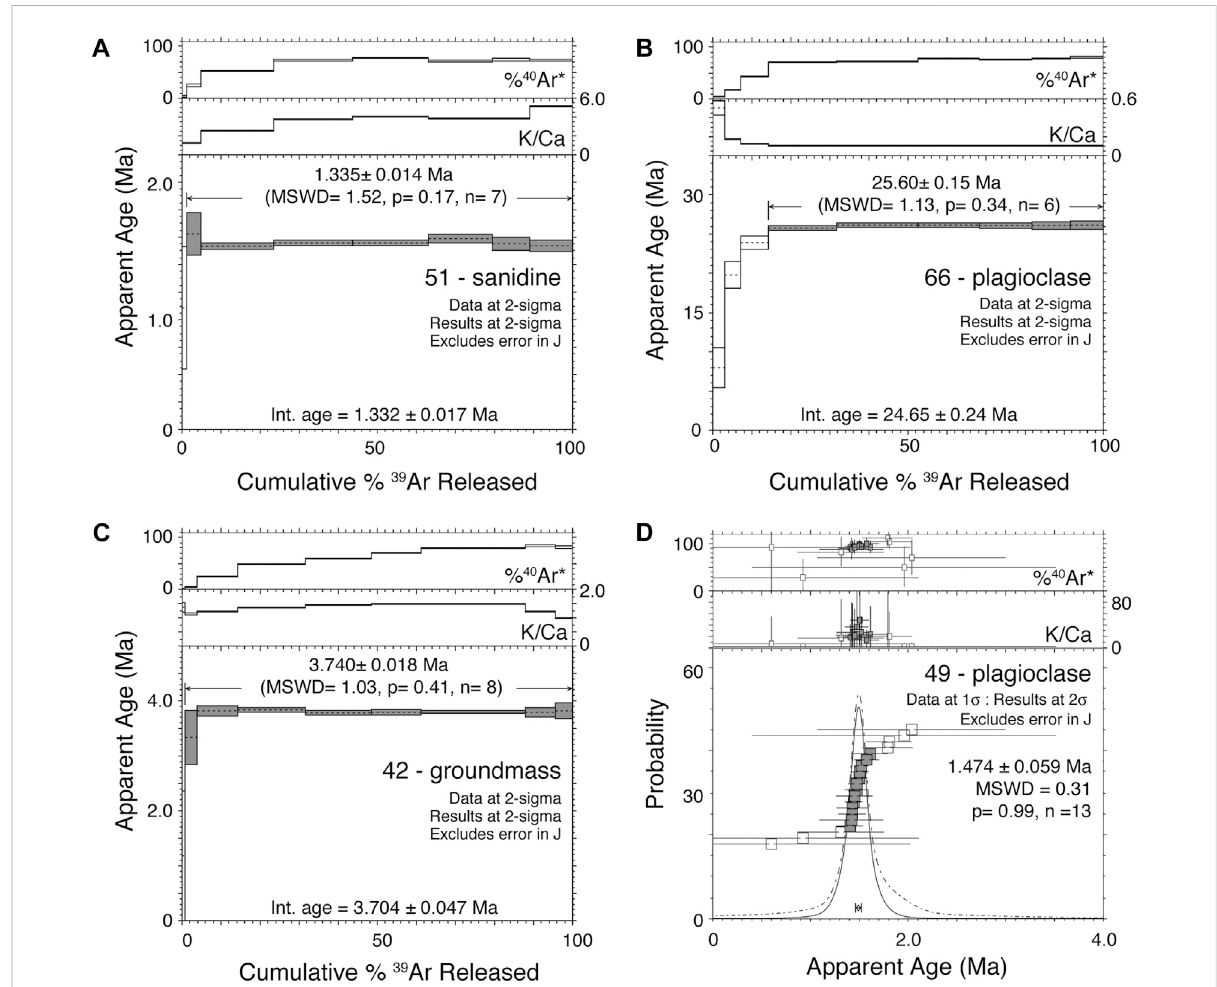
FIGURE 5 Typical plateau age spectra showing representative analyses of Intersalar Range lavas: (A) sanidine plateau age (sample #51) (B) plagioclase plateau age (sample #66) (C) phenocryst-free groundmass age (sample #42); and (D) plagioclase probability age (sample #49).